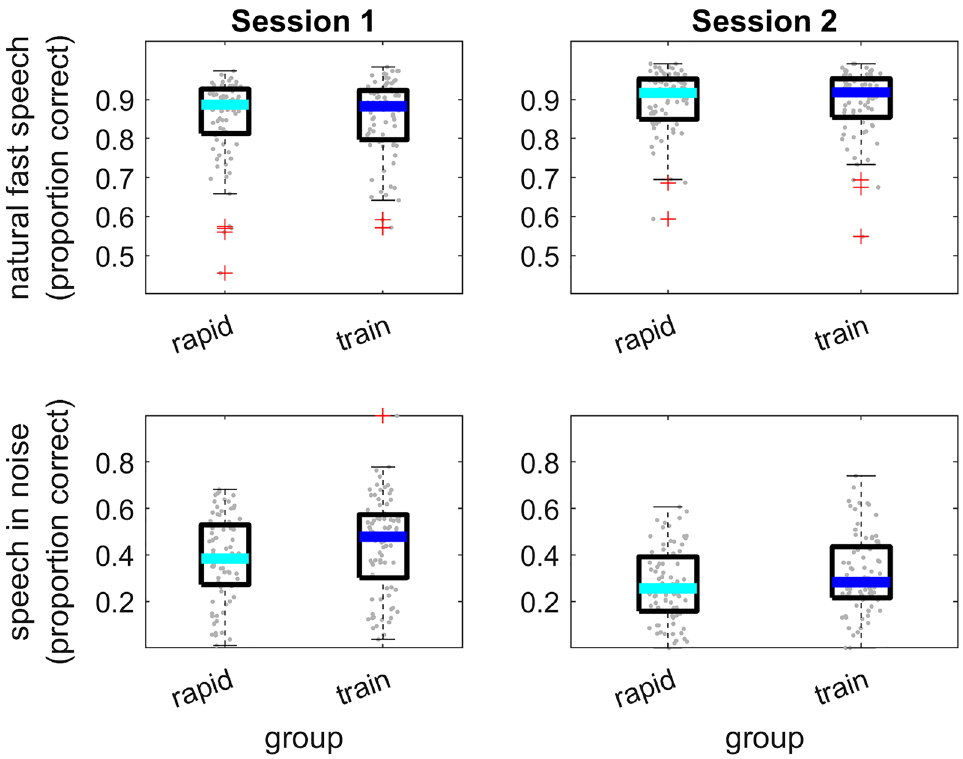
Figure 4. Perception of natural-fast speech and speech-in-noise as a function of group and session. rapid = rapid-learning group; train = training group. Background symbols denote mean individual data across sentences. The thick line within each boxplot shows group median; box edges mark the interquartile range; whiskers are 1.5 times the interquartile range; + signs are values outside of the 1.5 × interquartile range.